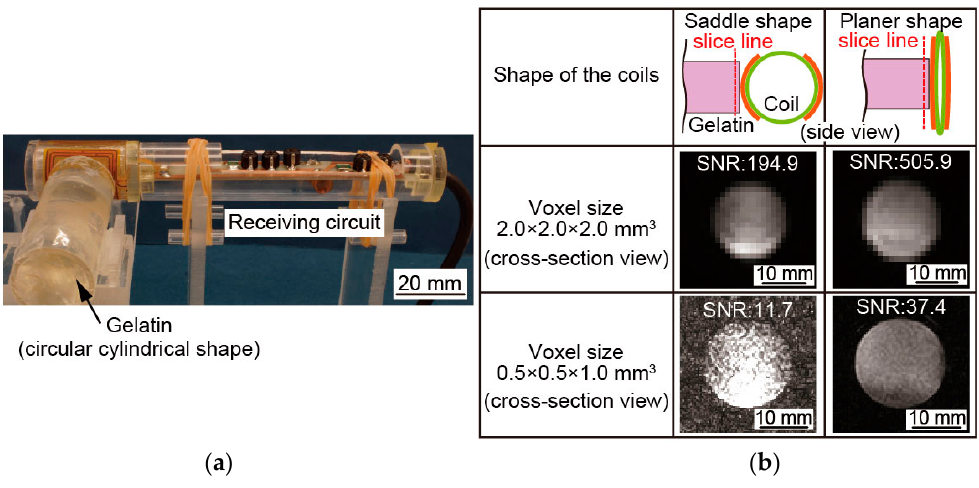
Figure 7. Experimental setup of signal-to-noise ratio (SNR) measurement and the taken MRI images of SNR measuring experiment. ( a ) Experimental setup; ( b ) MRI images of SNR measurement.